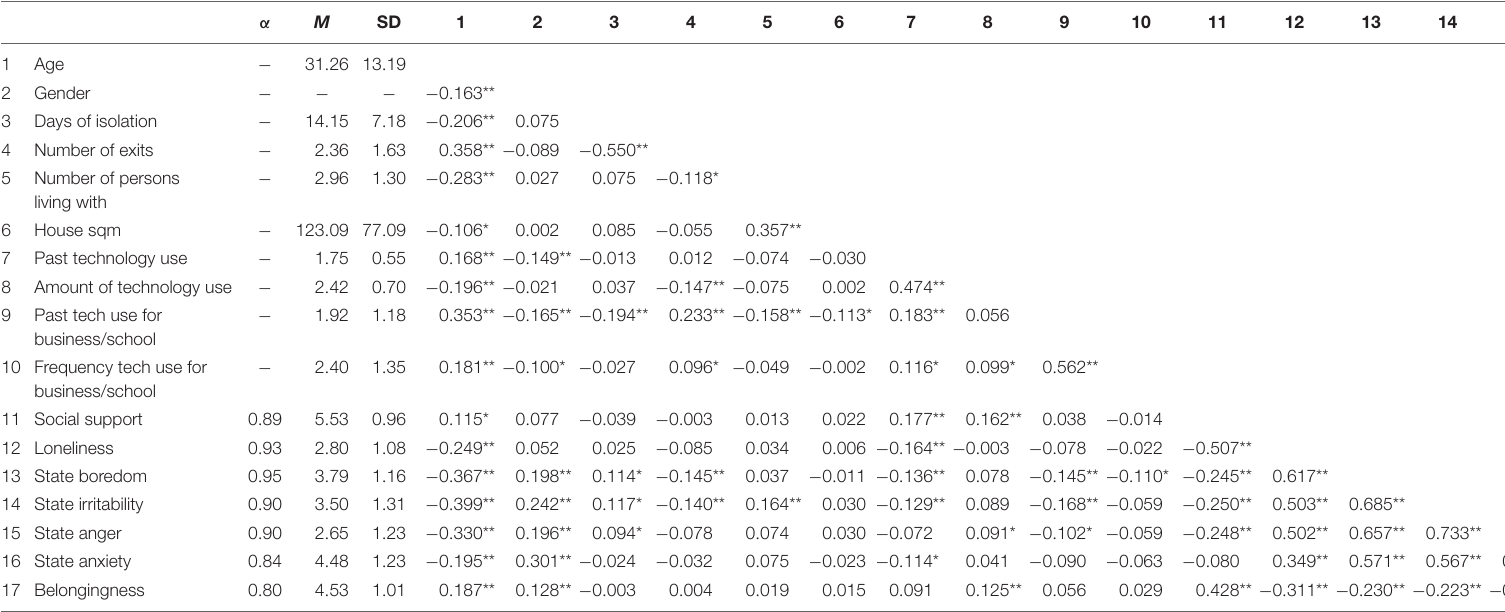
TABLE 2 | Descriptive statistics and correlations among variables.